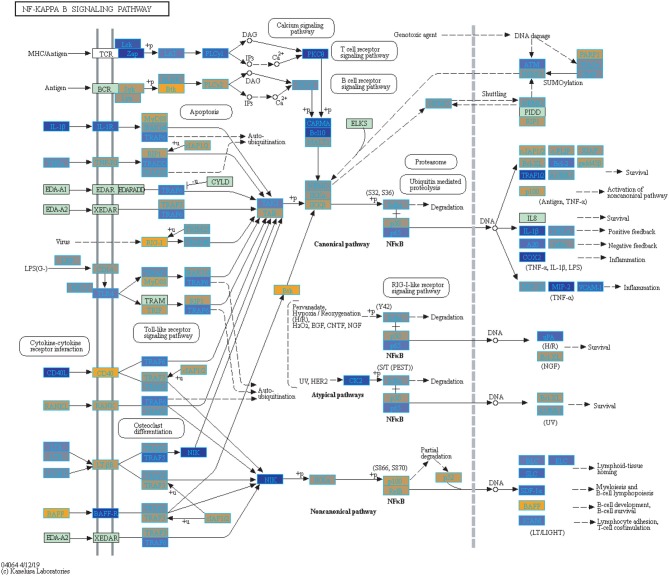
Highlighted NF-Kappa B Signaling KEGG Pathway (hsa04040) with Enriched Genes from the LRT Analysis (Bonferroni-adjusted p < 0.05) for Influenza Vaccinated Subjects (47–49). Yellow-colored genes are up-regulated and blue-colored genes are down-regulated in Influenza Vaccinated Subjects.